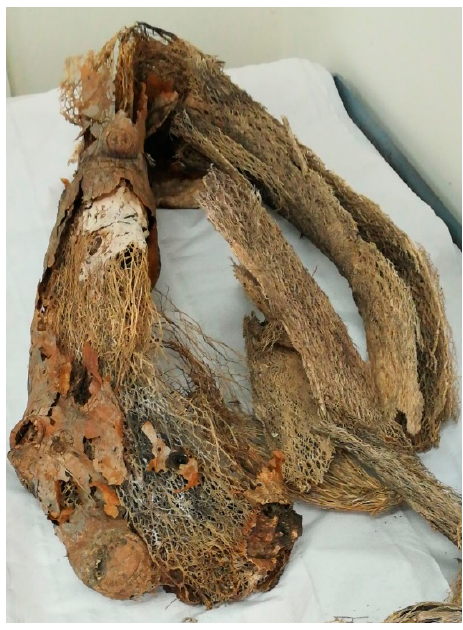
Figure 1. Fibrous waste material as received.